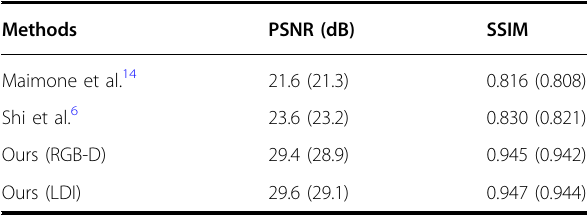
Table 2 Methods comparison on the validation set